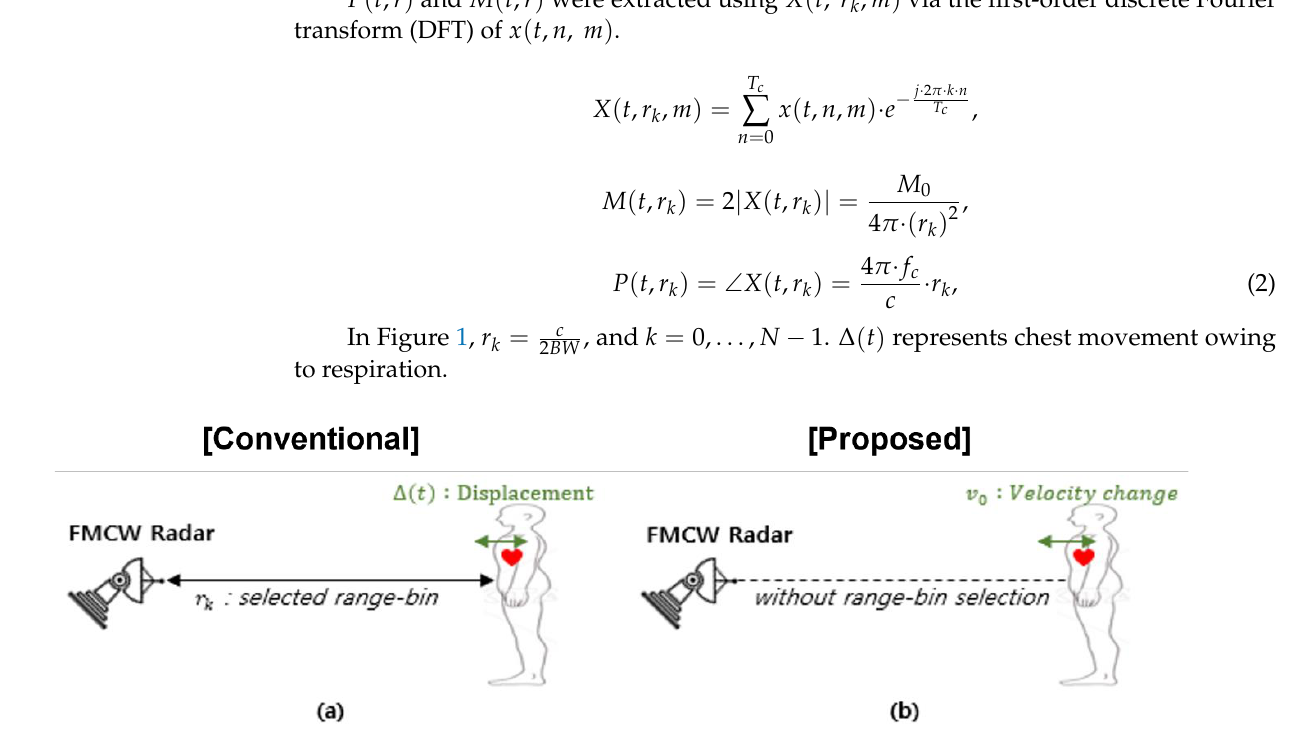
Figure 1. Comparison of conventional and proposed approaches. ( a ) Conventional method to measure respiration using the displacement between the radar and subject’s chest, which changes owing to the subject’s respiration. ( b ) Proposed method to measure respiration using the change in chest velocity, which changes owing to the subject’s respiration.